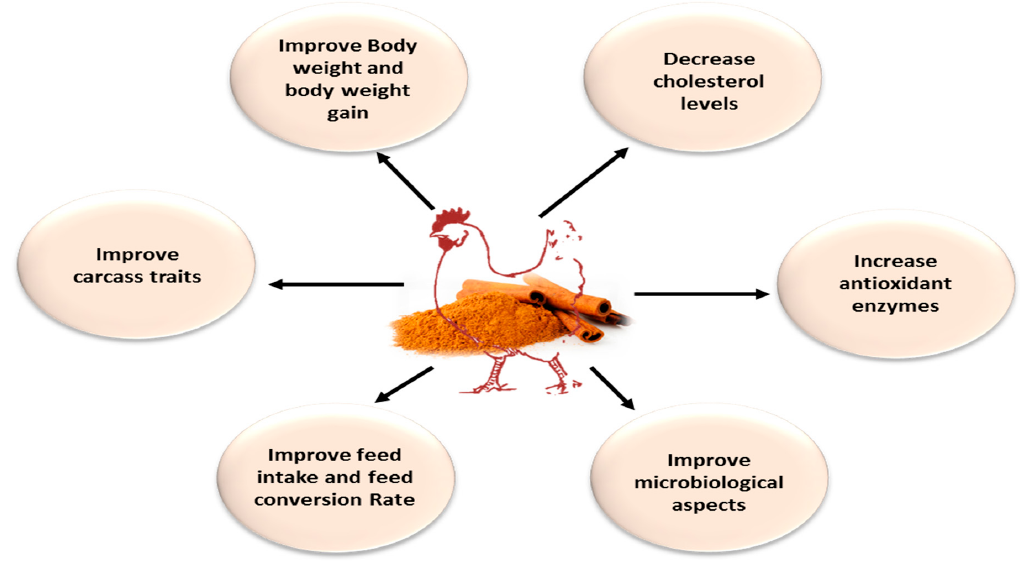
Figure 1. Advantages of dietary supplementation of cinnamon oil in poultry diet.